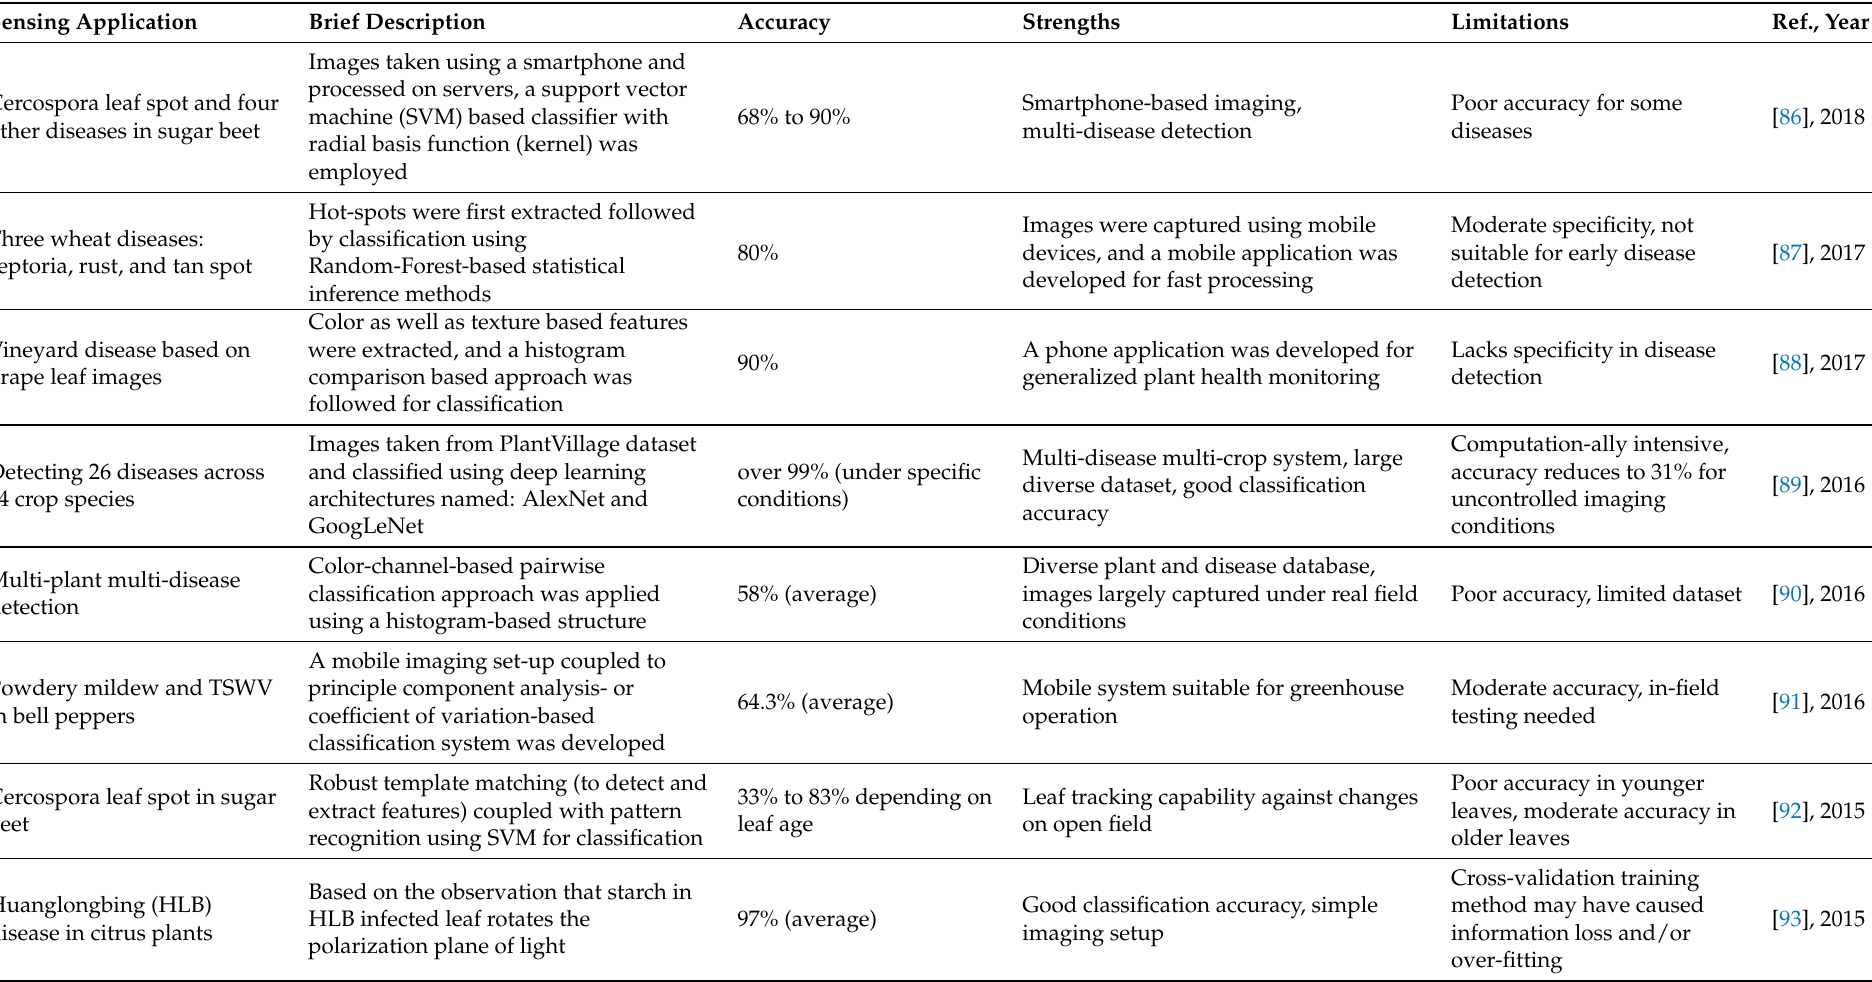
Table 3. A comparison of the key recent visible/RGB-imaging-based sensing methods for monitoring pathogenic stress in